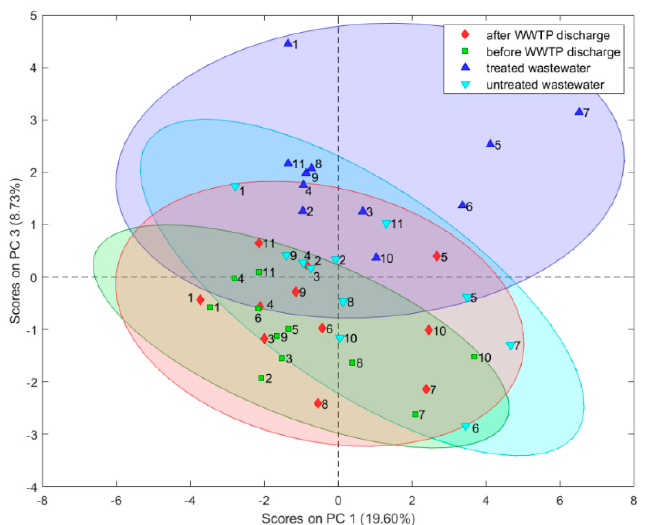
Figure 5. PC1 vs. PC3 factor scores plot.